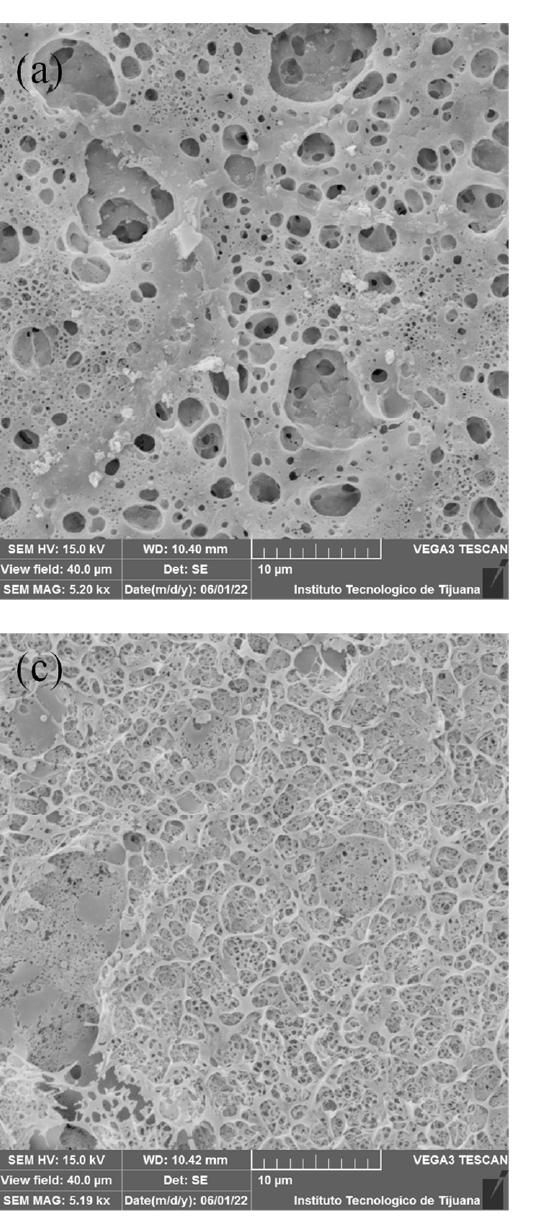
Figure 3. SEM images for membranes containing PEI: ( a ) M1, ( b ) M2, ( c ) M3 y ( d ) M4. Cross-section micrographs of membranes M1-M4 and F1-F4 are presented in Figure